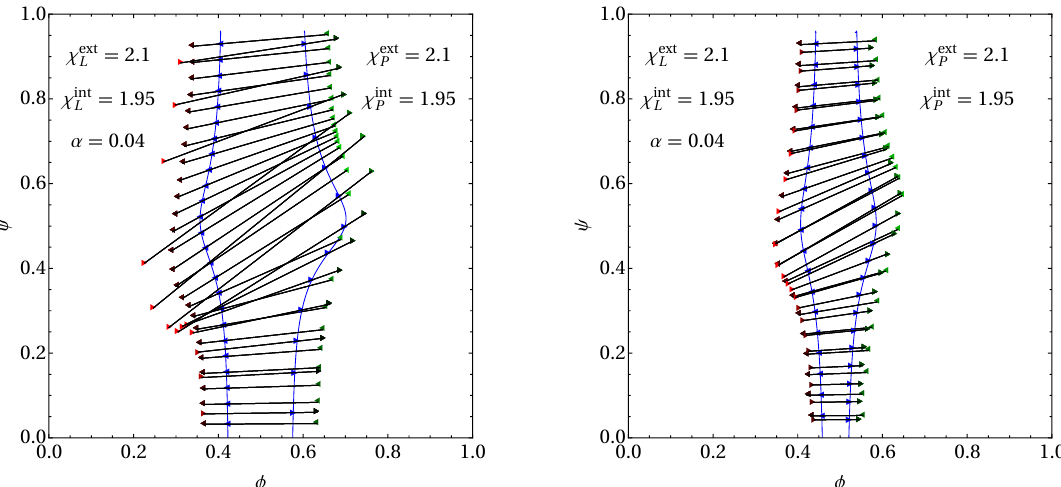
Figure 6. Sections of { φ , ψ , α } phase diagrams at α = 0.04 for transmembrane proteins (left diagram) and peripheral proteins (right diagram), calculated for χ ext and Λ = 0.05. Both diagrams show a number of selected tie lines, calculated at positions on the spinodal marked by blue triangles. The α -values of the two coexisting phases (at the end of each tie line) are color-coded according to the legend in the bottom right diagram of Figure